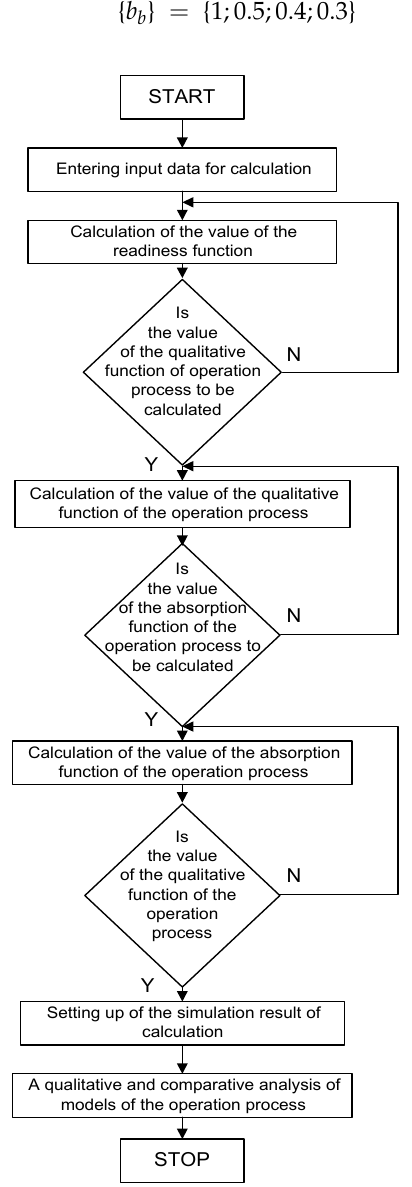
Figure 4. Algorithm of simulation investigations concerning the quality of the assessment of the operation process of the technical object.